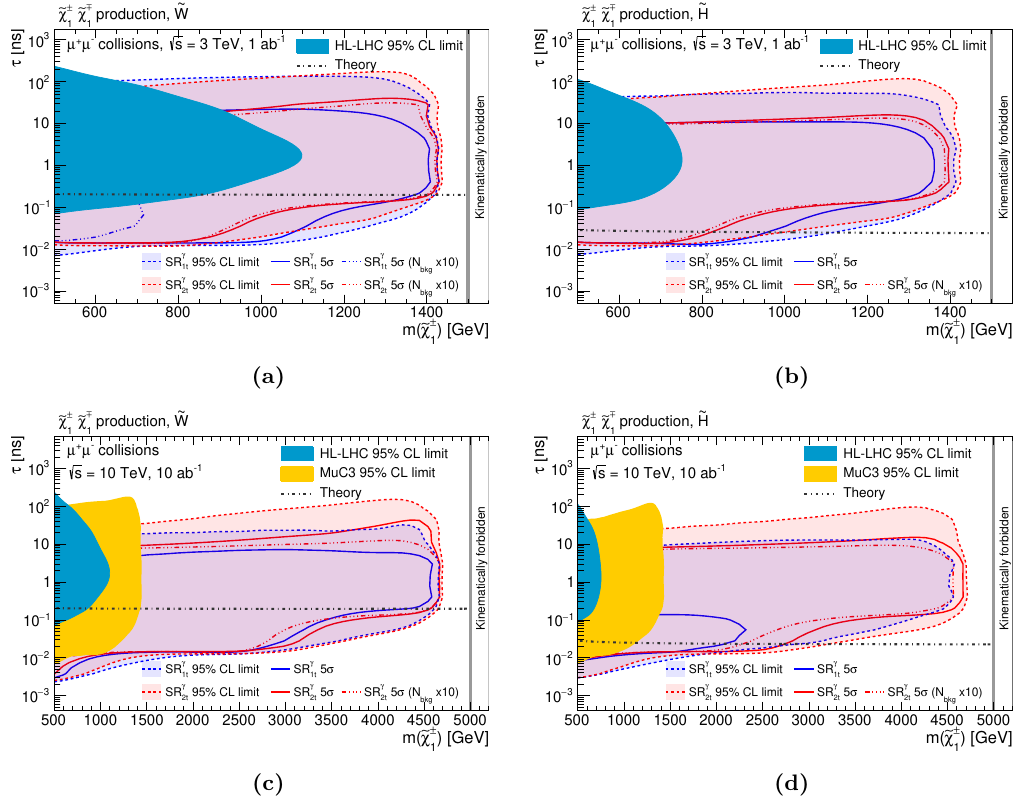
Figure 14. Expected sensitivity using 1 ab − 1 of 3 TeV or 10 ab − 1 of 10 TeV µ + µ − collision data as a function of the ˜ χ ± mass and lifetime. Models including ˜ χ ± ˜ χ ∓ are considered assuming pure-wino scenarios (a and c) and pure-higgsino scenarios (b and d). The ˜ χ ± lifetime as a function of the ˜ χ ± mass is shown by the dashed grey line: in the pure-wino scenario it was calculated at the two-loops level [98], in the pure-higgsino scenario it was calculated at the one-loop level [30, 64].